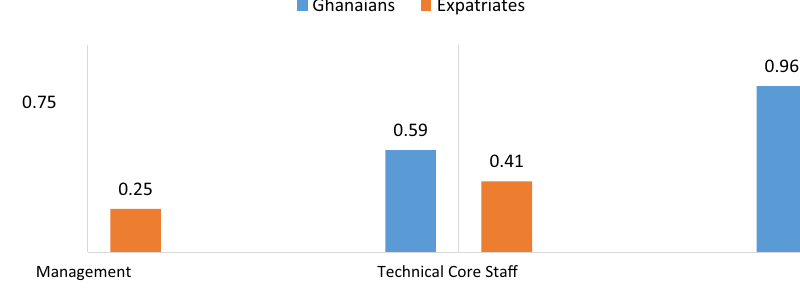
Fig. 3 Upstream employment roles in Ghana (Source: